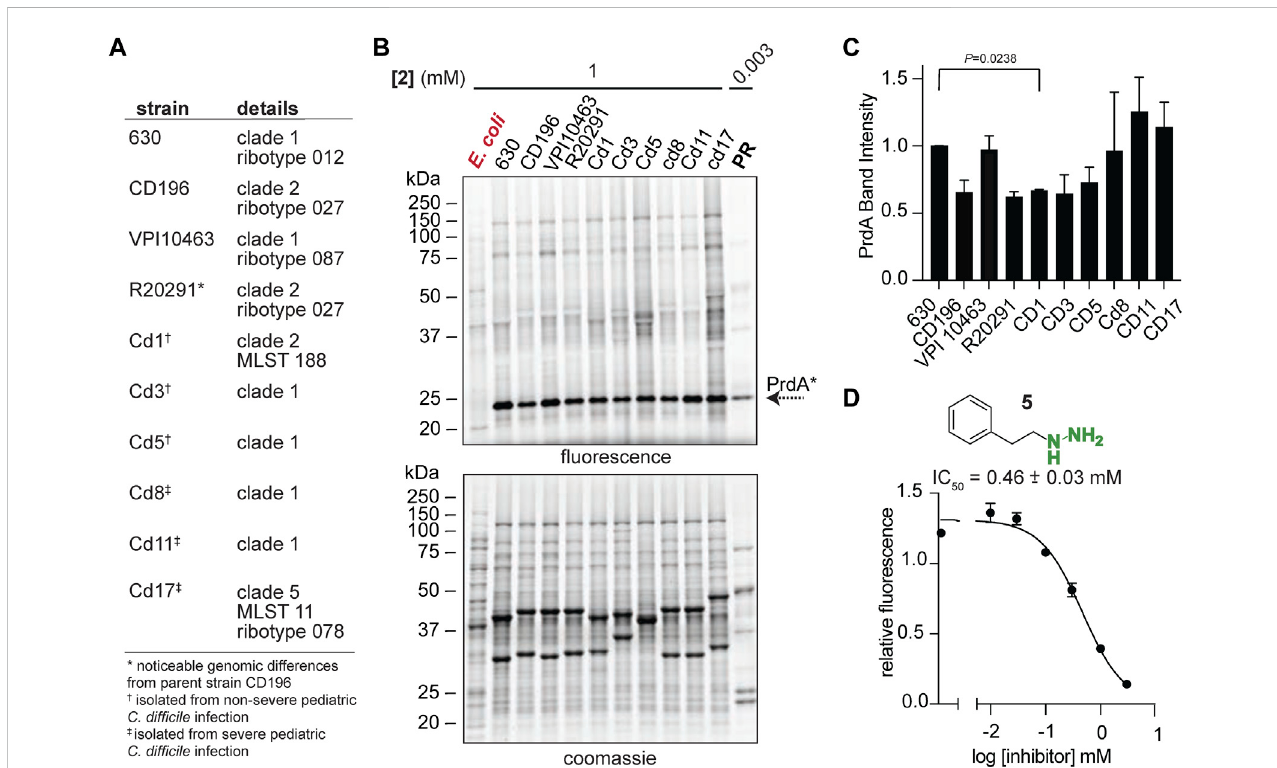
FIGURE 5 Pvyl-dependent PR activity is conserved. (A) , C. dif fi cile laboratory strains, classical epidemic strains, and clinical strains isolated from pediatric patients with CDI. (B) , Gel-based proteomic pro fi les of C. dif fi cile strains in (A) treated with 2 in mid-log phase ( upper ). 2 -labelled puri fi ed PR is included as a control. Corresponding expression pro fi les are shown after Coomassie staining ( lower ). (C) , Relative band intensities of Pvyl-PR in (B) normalized against expression. Pvyl-PR in strain 630 set to a relative intensity of 1 (mean ± SEM, n = 2, multiple pairwise t -tests using Prism9, p < 0.05 is signi fi cant). See Supplementary Figure S20 for stationary phase treatment. (D) , Inhibition curve of phenelzine ( 5 ) for PR. Averages from three independent experiments along with standard error are shown and fi tted to a non-linear regression function [log (inhibitor) vs. response] in Prism 9. The IC 50 value and standard deviation were calculated from non-linear regression functions from three independent experiments. See Supplementary Figure S21 for fl uorescence assay schematic and additional inhibition